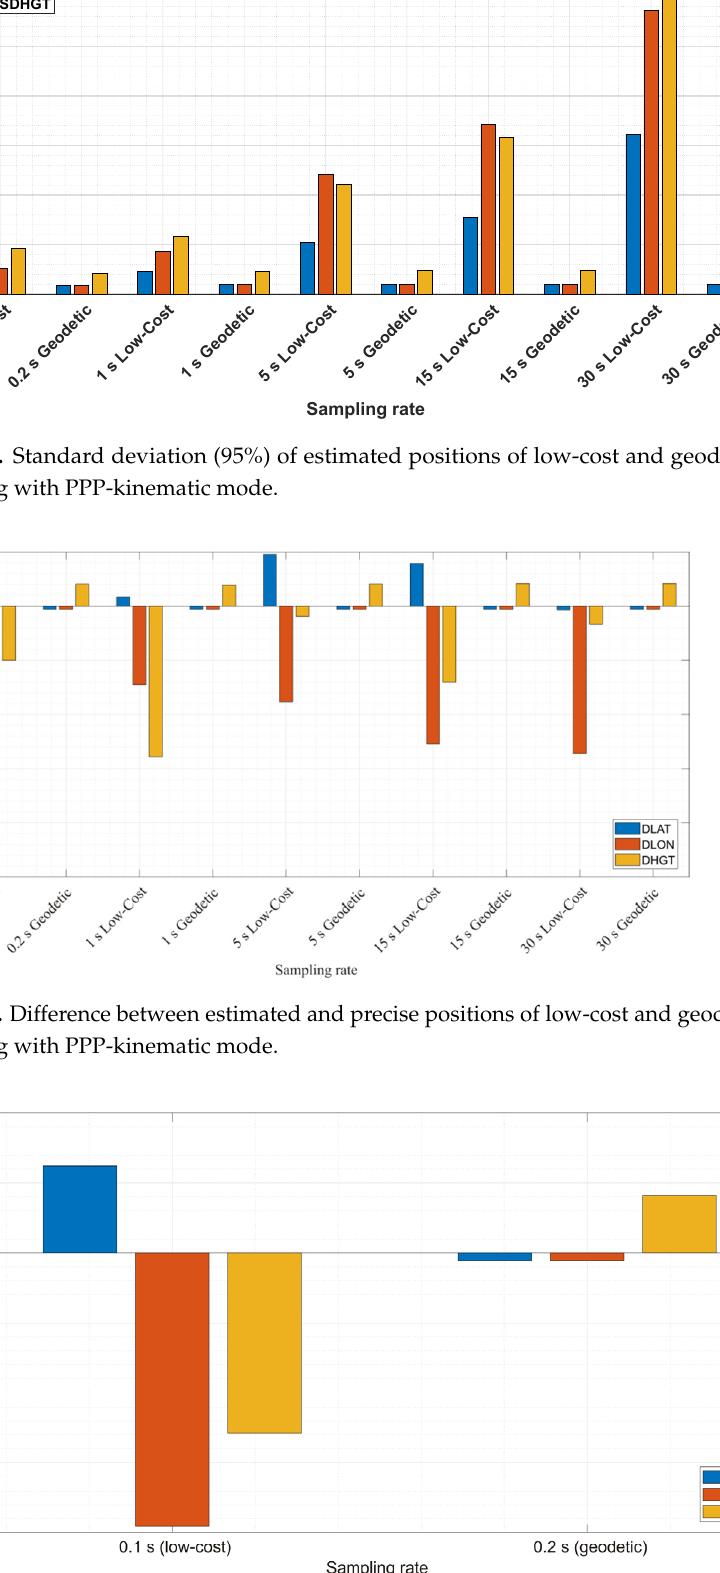
Figure 13. Standard deviation (95%) of estimated positions of low-cost and geodetic receivers at 0.1 and 0.2 s respectively, by processing with PPP-kinematic mode. The obtained differences of the precise coordinates and estimated coordinates for the low-cost GNSS receiver are higher than the geodetic receiver in all cases (Table 3). In com- parison to the static mode, where the behavior of the difference of 1 s is similar to the geodetic receiver, this is not found. In all cases the standard deviation of the low-cost GNSS is greater than the geodetic receiver. 0.1 s (low-cost)